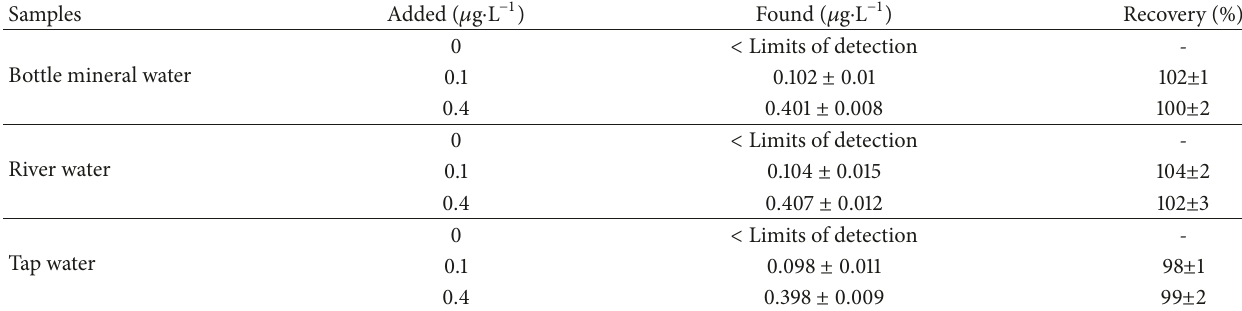
Table 4: Determination of Sb (III) in water